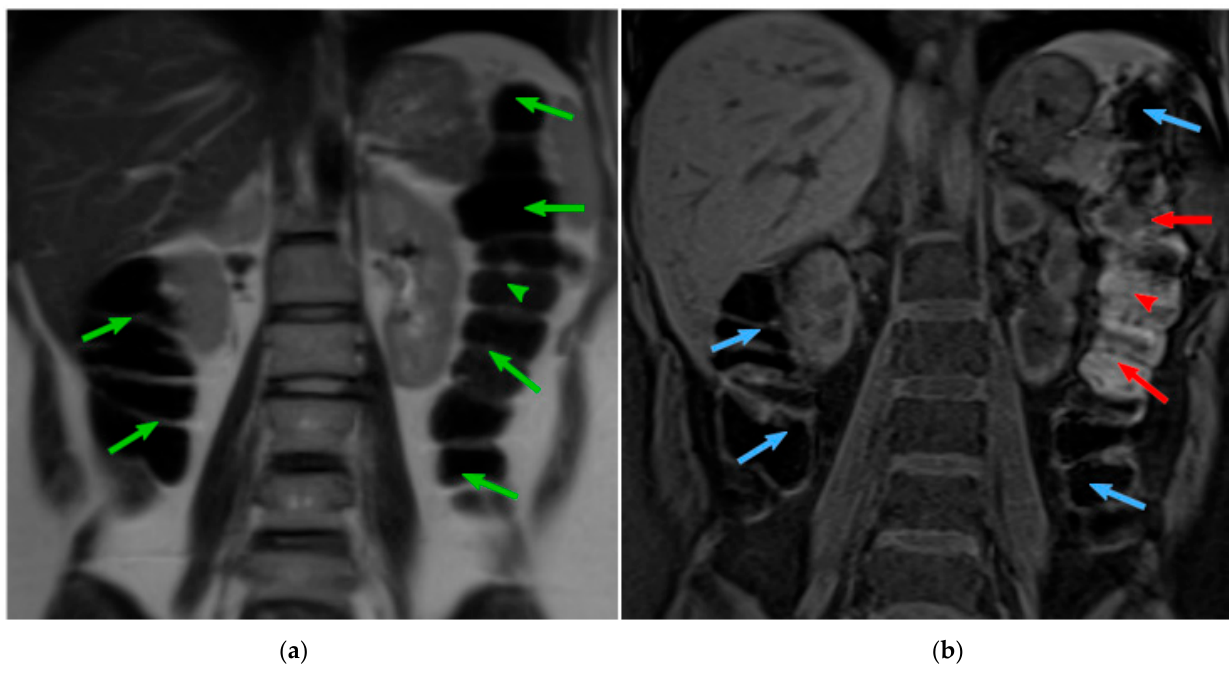
Figure 1. ( a ) MRI T2 coronal slice showing ascending colon and descending colon (green arrows). ( b ) The same area in the T1-FS modality. Arrows are colorized depending on the contents: blue arrows point to gas and red to feces. Courtesy of [7].